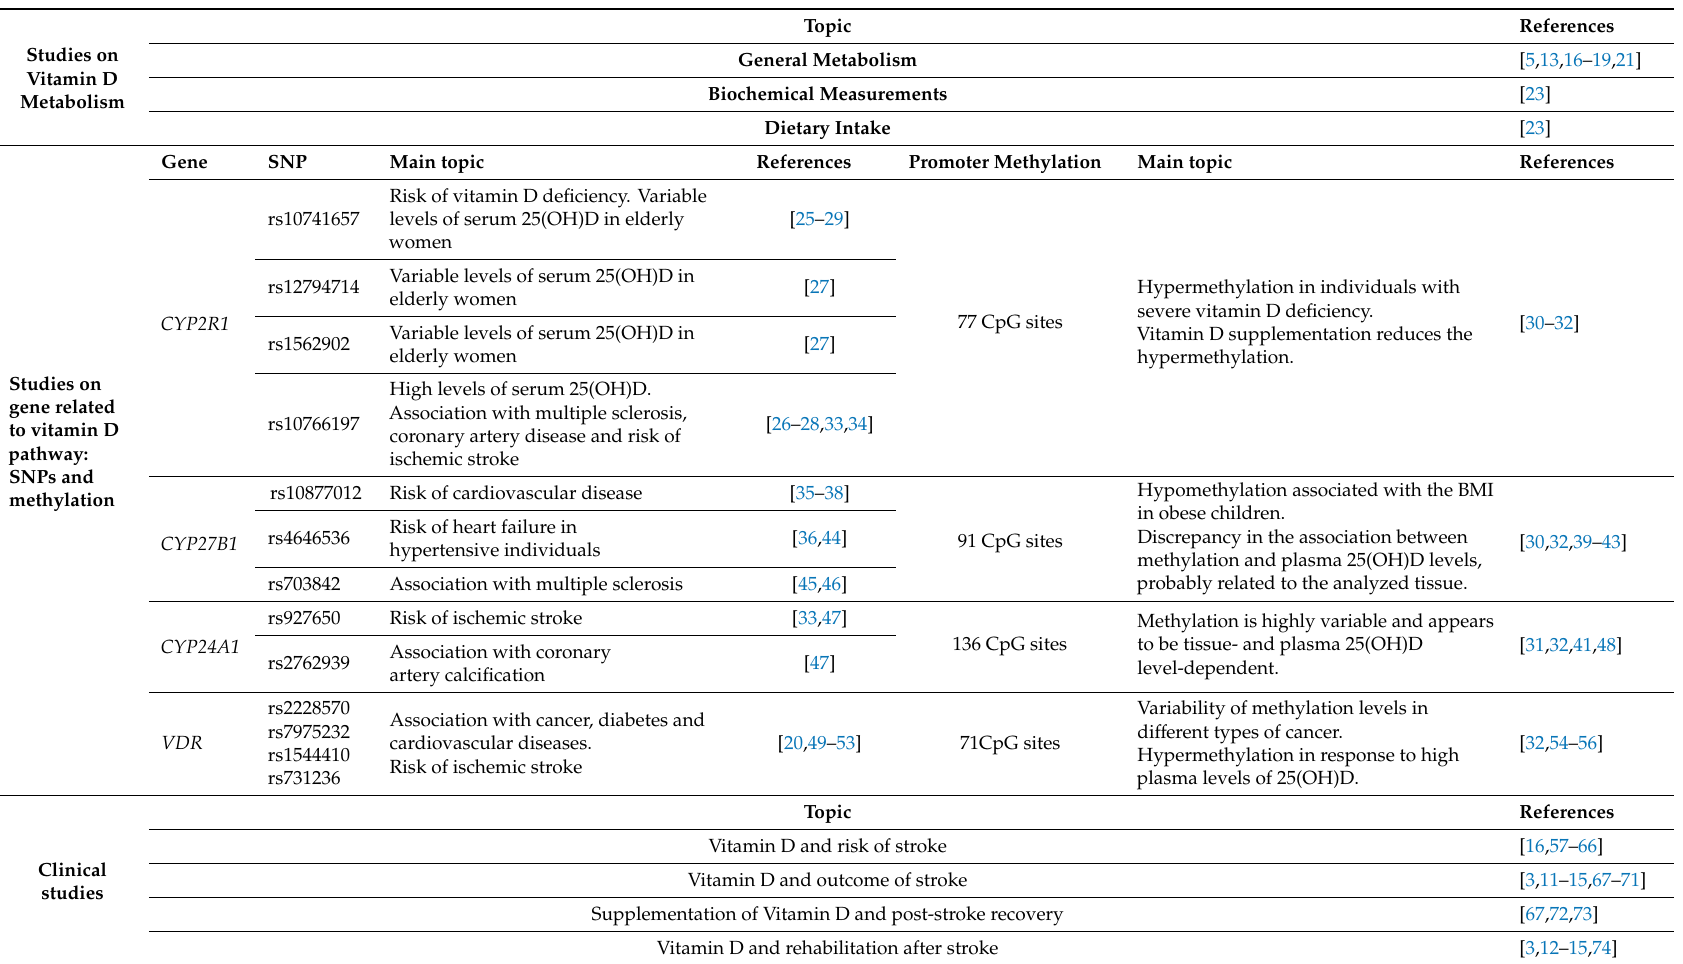
Table 1. Schematic representation of main topics treated in the review with relative